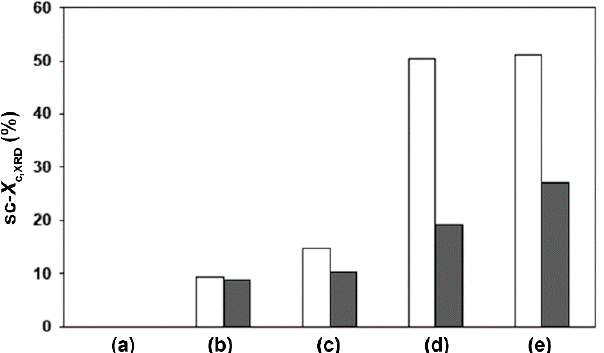
Figure 3. Stereocomplex crystallinity (sc- X c,XRD ) values of ( (cid:3) ) non-chain-extended and ( (cid:4) ) chain- extended scPLA films with PLLA/PDLA ratios of (a) 100/0, (b) 90/10, (c) 80/20, (d) 70/30 and (e) 60/40 ( w / w ).